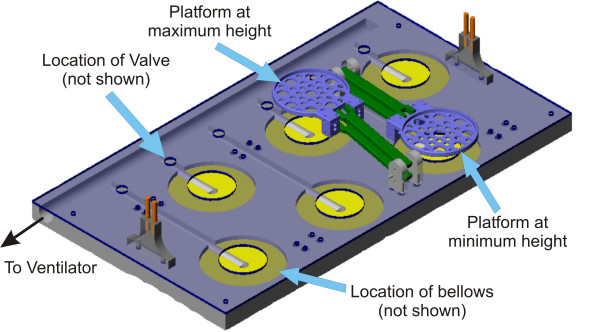
A 3D drawing of the model. The overall view of the model including relative locations of the bellows and the valves, as well as the position of weight platforms. Only 2 platform/supporting arm assemblies are shown for clarity.